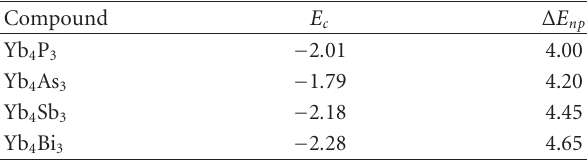
Table 10: The centers of gravity E c relative to the Fermi energy